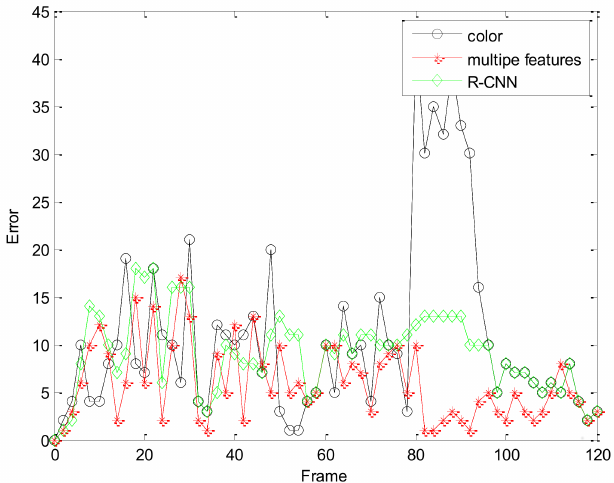
Figure 23. The RMSE comparison corresponding with R-CNN.